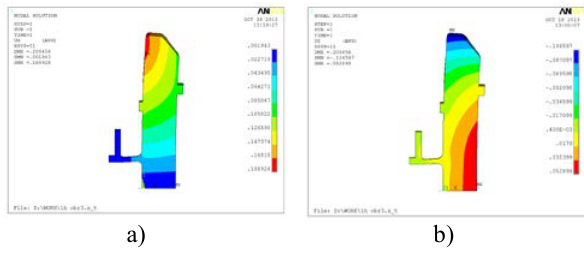
Fig. 10. Equivalent tensions in sector (a) and into the grinding head opening (b).